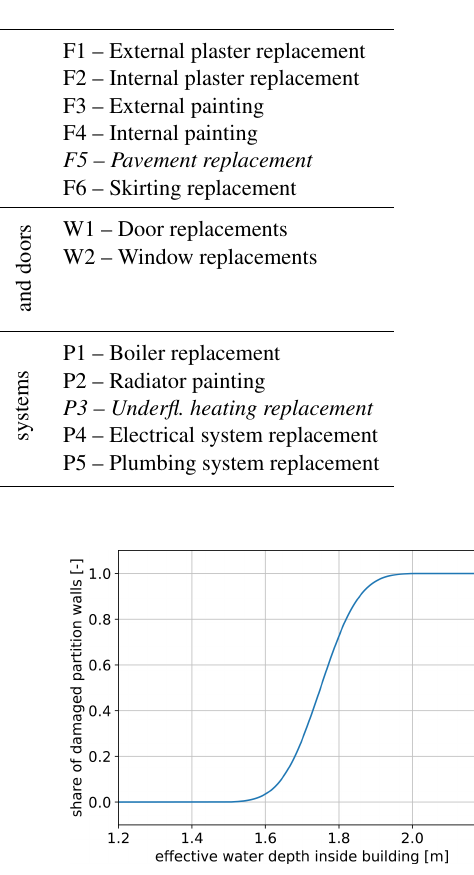
Figure 4. Fragility function for partition walls relative to water